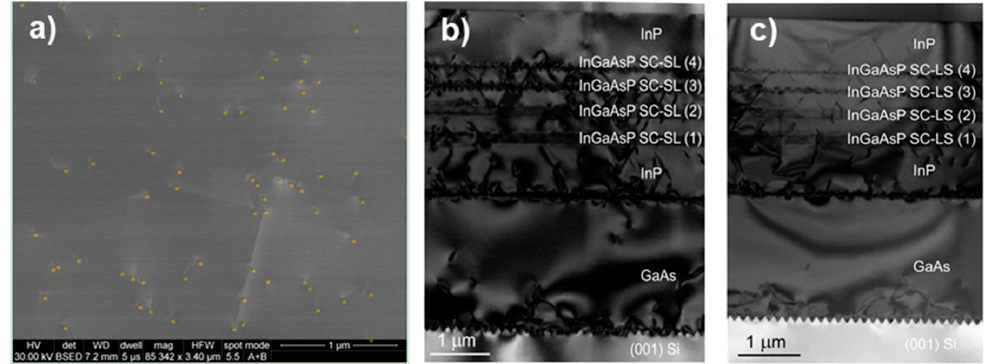
Figure 6 . ( a ) Plain view ECCI image of the final epitaxial structure, ( b , c ) TEM cross-section TEM images showing the epitaxial stack. The SC-SLs are clearly visible and they are ordered 1–4 as listed in Table 1.